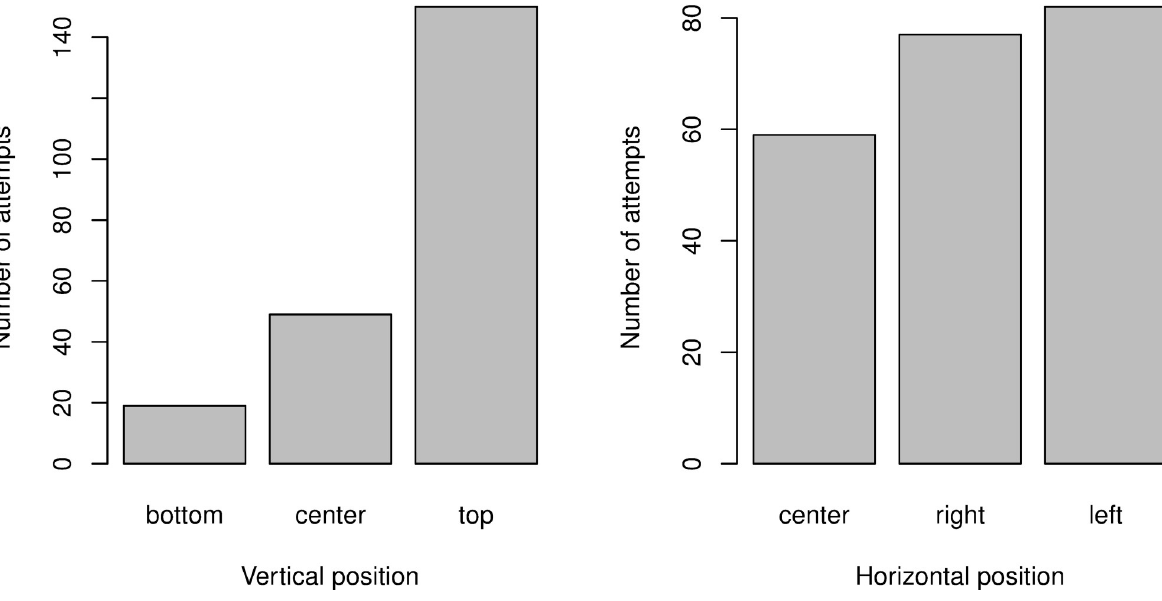
Fig 4. Horizontal and vertical positions of escapement attempts.